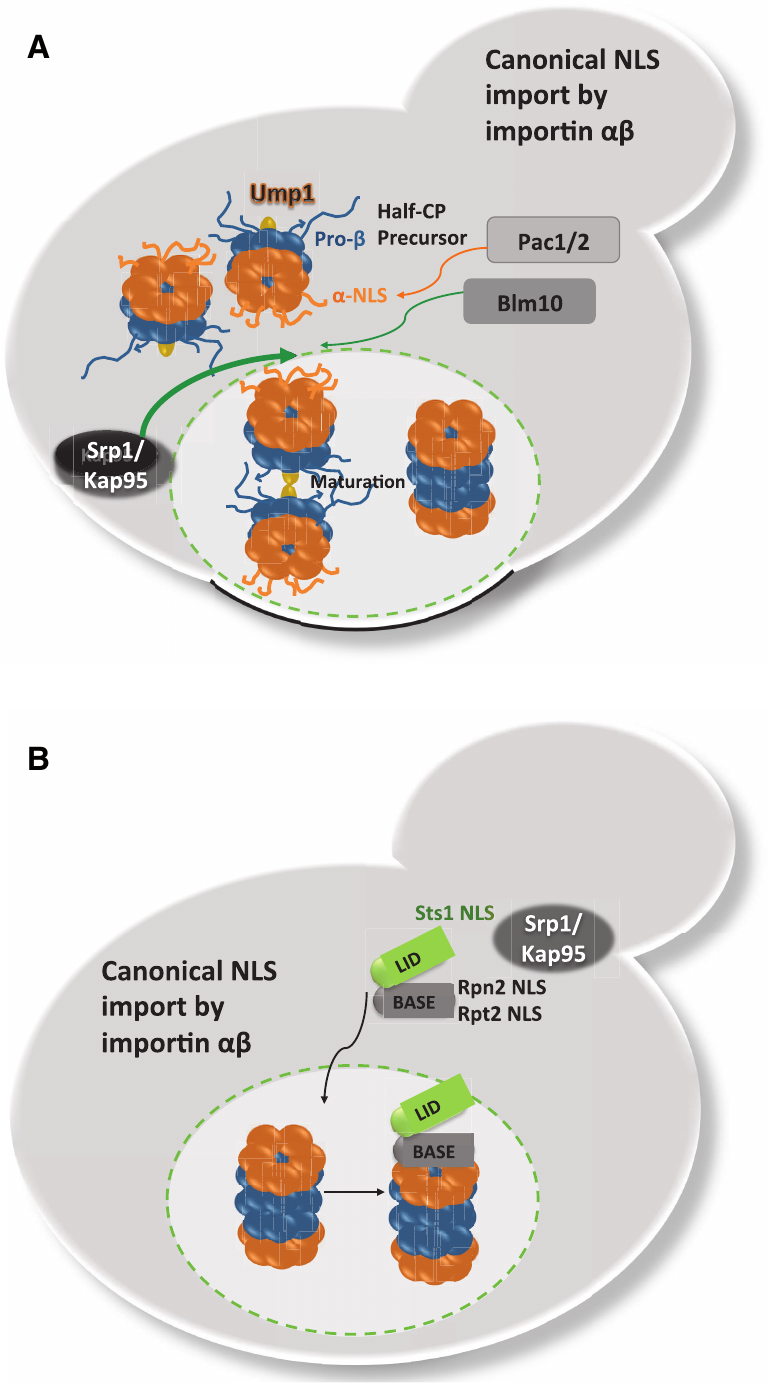
Figure 1. Model of nuclear proteasome assembly based on nuclear import of CP precursor complexes and RP subcomplexes in proliferating yeast cells. ( A ) Ump1-containing CP precursor complexes are mainly imported into the nucleus by Srp1/Kap95, the classical importin/karyopherin αβ pathway. The α rings with the classical NLS are depicted in red. The β rings with propeptides are depicted in blue. The CP-dedicated chaperone and maturation factor Ump1 is depicted in yellow. The completion of CP maturation occurs in the nucleus with the degradation of Ump1. CP-dedicated chaperones Pac 1/2 are masking the NLS within the α ring, possibly preventing premature nuclear import. Blm10 serves as an alternative import receptor. ( B ) Nuclear import of RP base and lid subcomplexes by the classical importin/ karyopherin αβ pathway. Rpn2/Rpt2 and Sts1 confer classical NLS to the RP base and lid complex, respectively. Sts1 is short-lived and most likely degraded with nuclear RP-CP